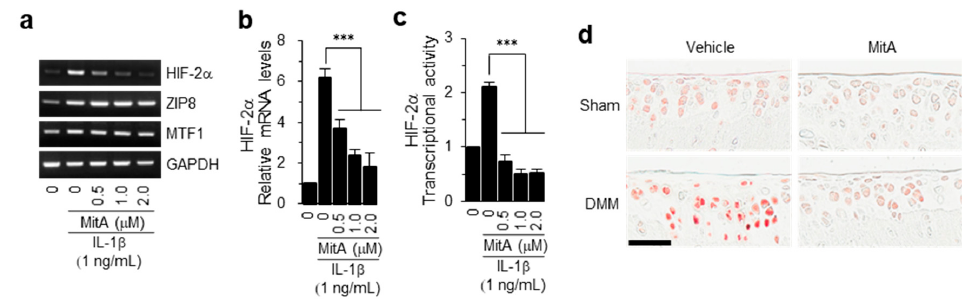
Figure 4. MitA inhibits expression of HIF-2 α in chondrocyte and OA cartilage tissue. ( a , b ) Expression of HIF-2 α is repressed in MitA-treated chondrocytes. Representative images of RT-PCR ( a ) and quantification using real-time PCR ( b ) are shown ( n ≥ 5). Values are means ± SEM (*** p < 0.001); ( c ) Effect of MitA on HIF-2 α activity. Transcriptional activity of HIF-2 α was assessed using hypoxia-response element (HRE) reporter assay in MitA-treated chondrocytes ( n = 4). Values are means ± SEM (*** p < 0.001); ( d ) HIF-2 α immunostaining of cartilage tissue collected from mice after DMM surgery and/or MitA IA injection. Scale bar: 50 μ M.